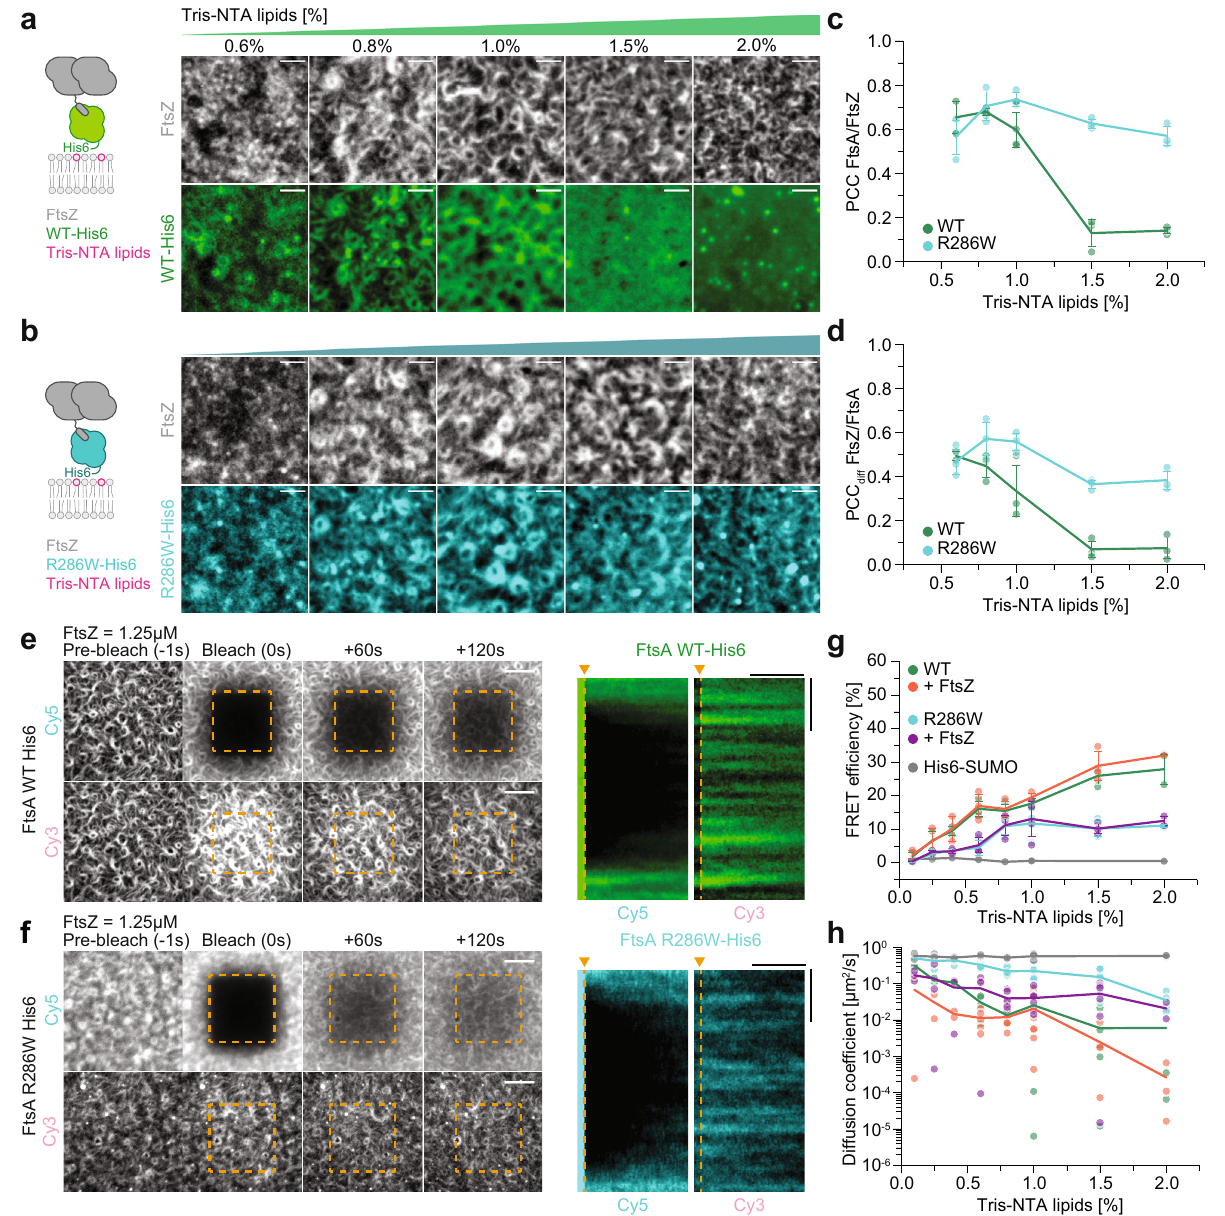
Fig. 4 Membrane diffusion and protein binding dynamics contribute to co-treadmilling of FtsA and FtsZ. a , b Representative micrographs of Alexa488- FtsZ (grey) and Cy5-FtsA WT-His6 (green) ( a ) or Alexa488-FtsZ (grey) and Cy5-FtsA R286W-His6 (cyan) ( b ) at increasing Tris-NTA lipid densities. Scale bars are 2 µ m. c Colocalization of FtsZ with WT-His6 (green) or R286W-His6 (cyan) quanti fi ed by PCC. d Dynamic colocalization of FtsZ with WT- His6 (green) or R286W-His6 (cyan) quanti fi ed by PCC diff . The experiments to measure PCC and PCC diff were repeated three times for each Tris-NTA lipid density. e , f Representative micrographs of acceptor bleaching recovery and donor intensity increase of FtsA WT-His6 ( e ) and FtsA R286W-His6 ( f ). Scale bars are 5 µ m. Right: Kymographs depicting the bleaching recovery, as well as the FRET signal for FtsA WT-His6 (green) or R286W-His6 (cyan). Scale bars are 4 µ m and 40 s, respectively. g While self-interaction of His-tagged FtsAs increases with increasing protein density, there was no FRET for His-SUMO detected. FRET signal for FtsA WT-His6 is higher compared to FtsA R286W-His6 and FtsZ has no effect on the self-interaction. h While the mobility of His-SUMO remains unchanged, the diffusion coef fi cient of His-tagged FtsAs decreases with increasing protein density. The experiments in g and h were replicated twice for Tris-NTA densities < 0.6% and three times for Tris-NTA densities > 0.6%. Dots in all plots represent independent experiments, thick lines indicate the mean and error bars depict the standard deviation. Source data are provided as a Source Data fi